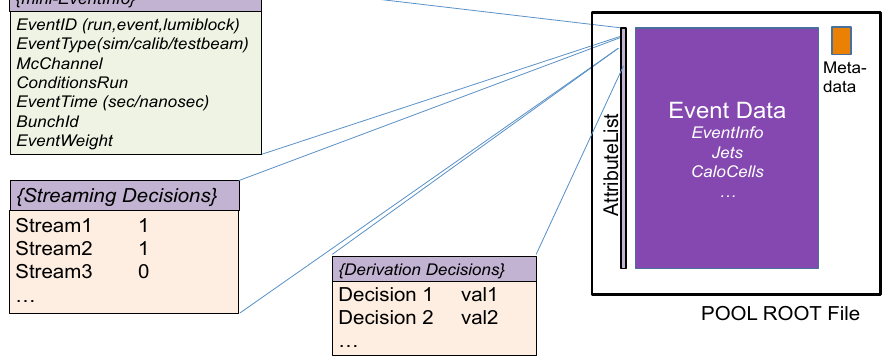
Figure 3. Out-of-band Event-level metadata in a data file for fast Event selection on